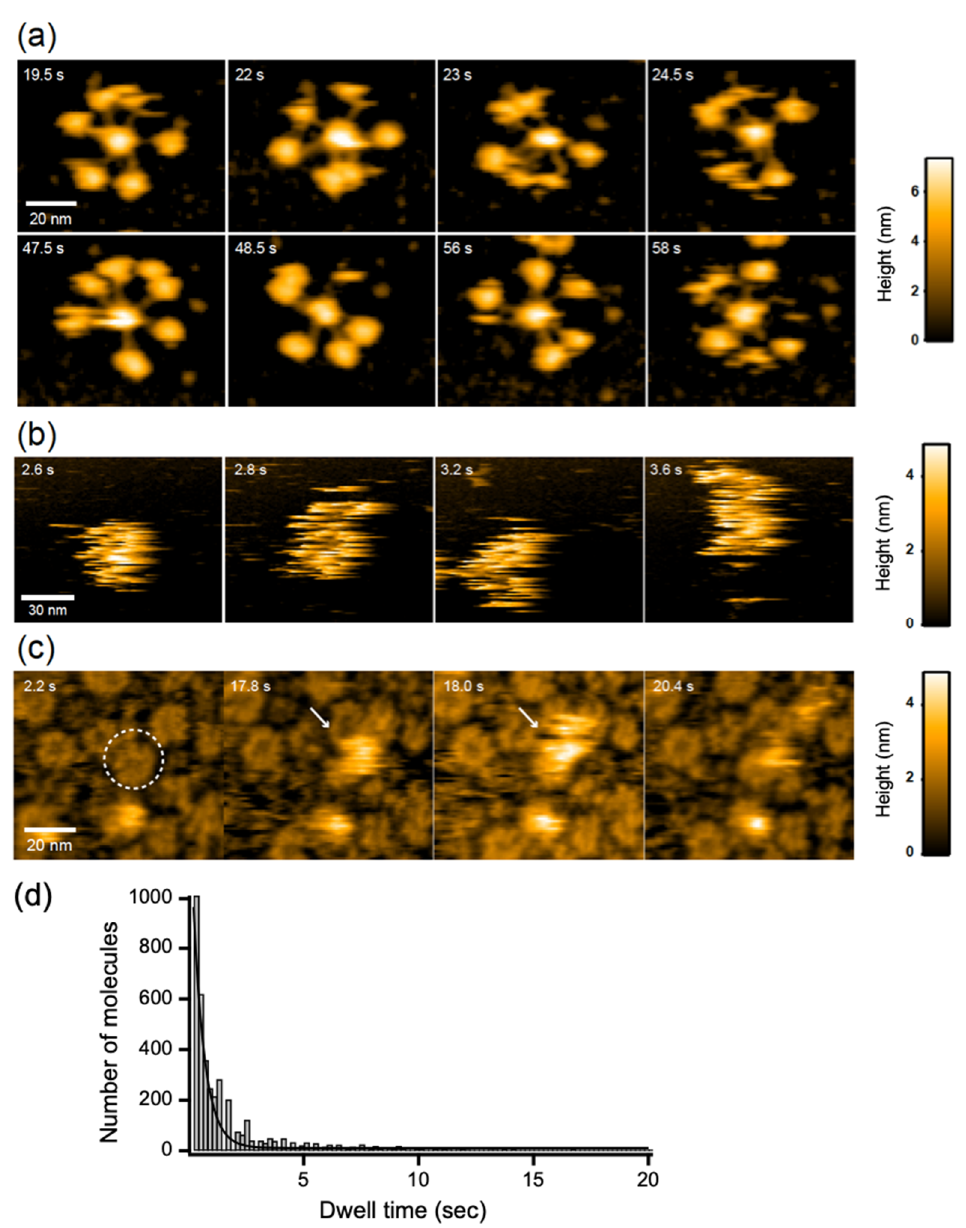
Figure 3. HS-AFM observation of C1q. C1q on ( a ) mica surface and DOPC membranes containing 50% GM1 in ( b ) the absence and ( c ) presence of GB2. A typical IgG hexameric ring is indicated by dotted circles. The C1q bound to the IgG ring is indicated by white arrows. ( d ) The dwell time of C1q on the IgG hexameric ring formed on the GM1-incorporated membrane.